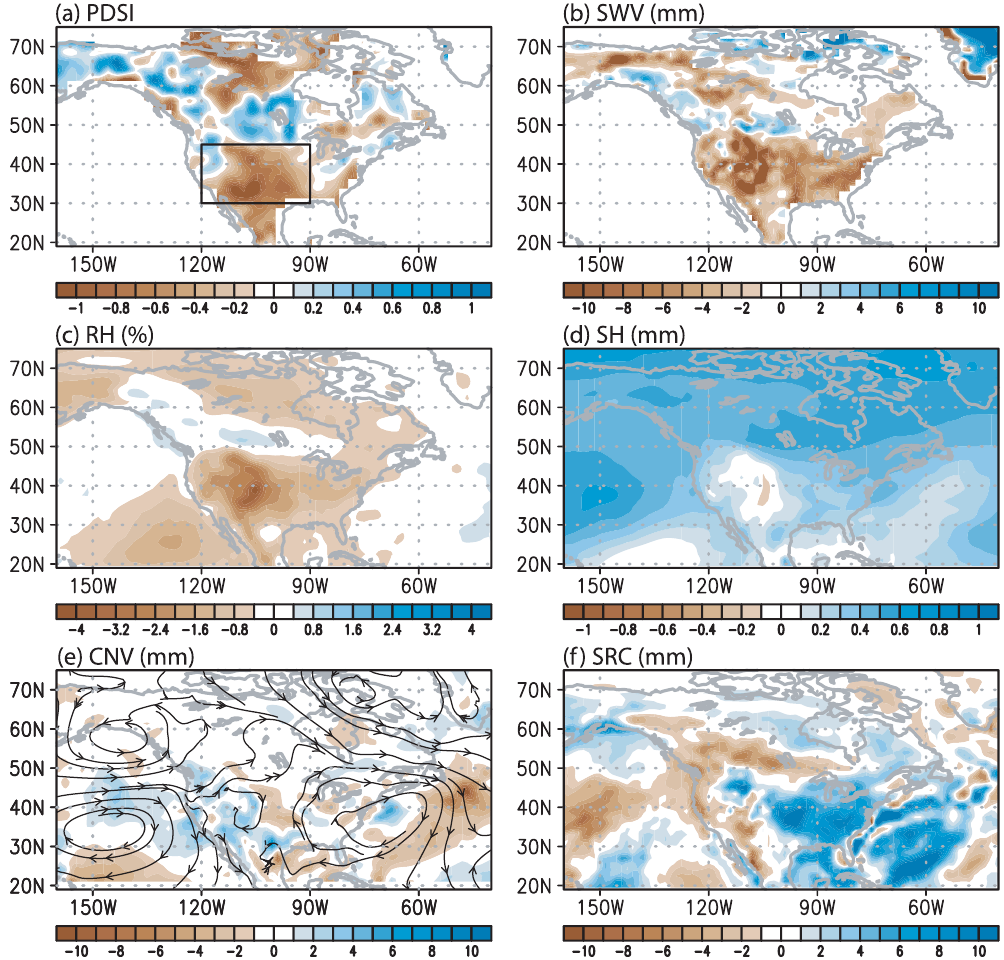
Figure 2. The regressed patterns of March–June averaged fields for the NH warming mode: ( a ) Palmer Drought Severity Index (fraction), ( b ) soil water volume (mm), ( c ) lower-tropospheric (1000–800 hPa) mean relative humidity (%), ( d ) lower-tropospheric moisture increase (mm), ( e ) lower-tropospheric moisture transport (streamline) and advection (mm), and ( f ) evaporation minus precipitation (mm). The boxed region [240°–270°E × 30°–45°N] in ( a ) is the main focus in the present study. This figure was created by using the Grid Analysis and Display System (GrADS) version 2.1 available at